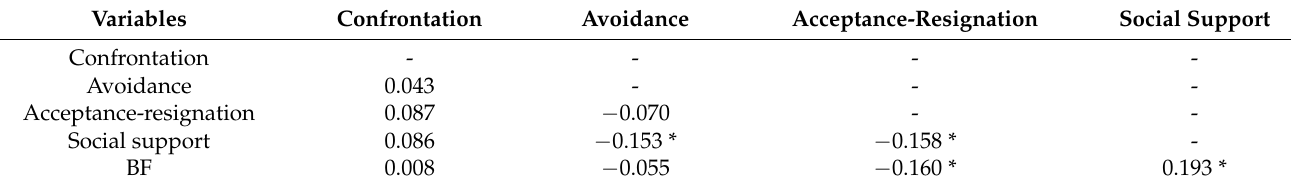
Table 3. Correlation analysis of BF, coping style, and social support